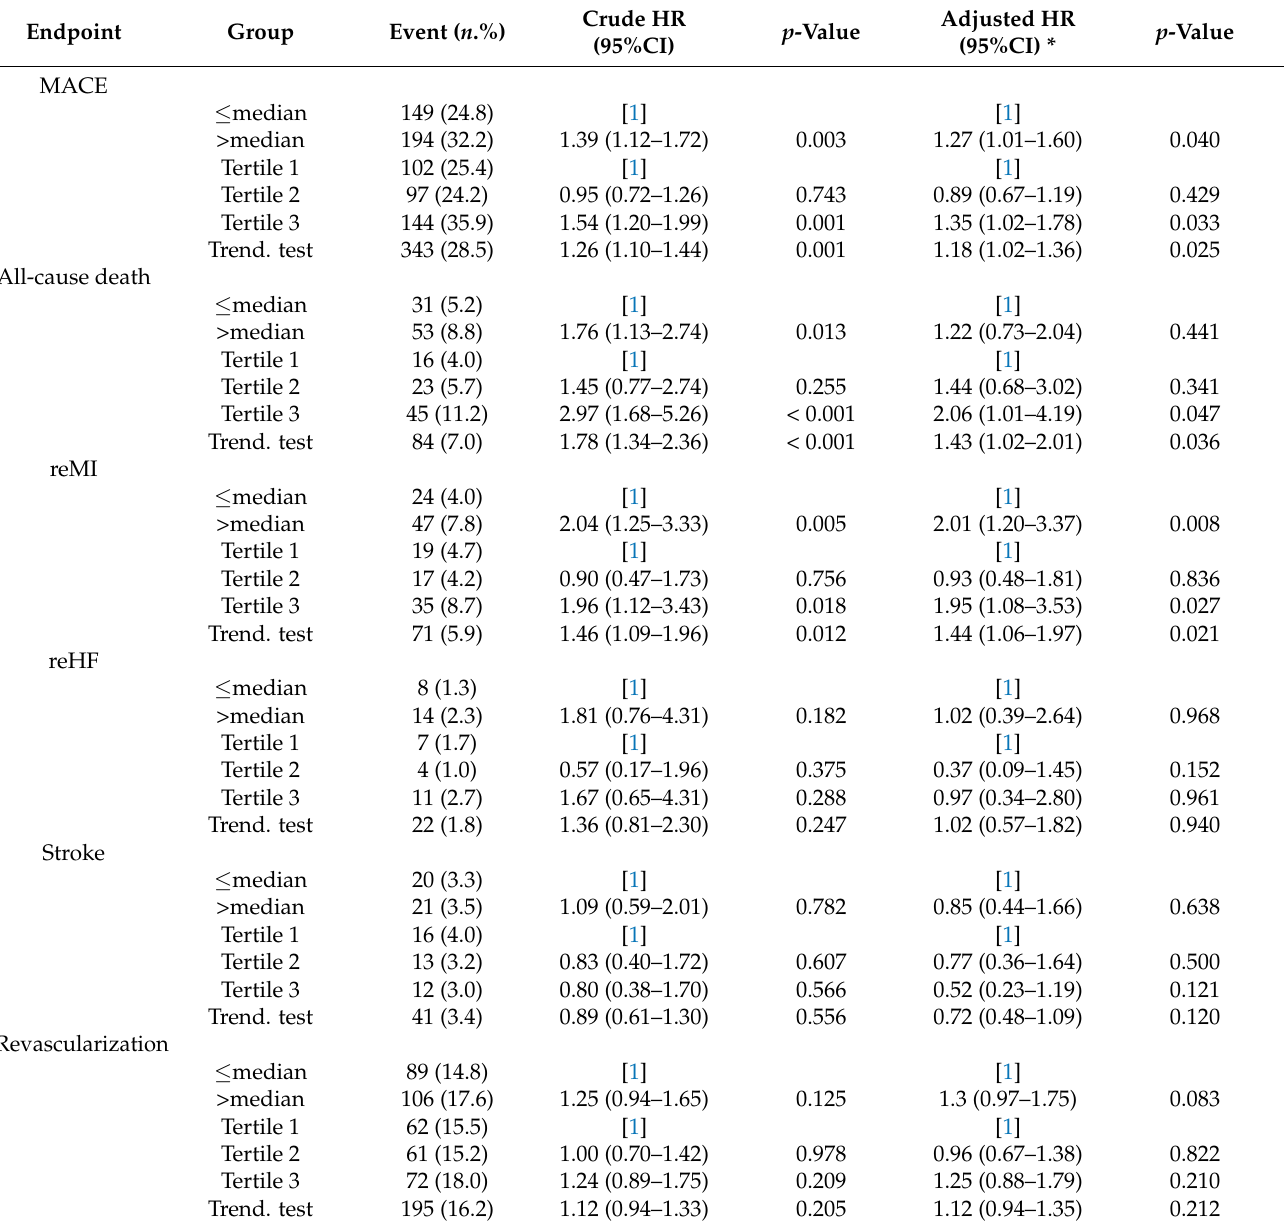
Table 2. Association between TMAO levels at enrollment and all